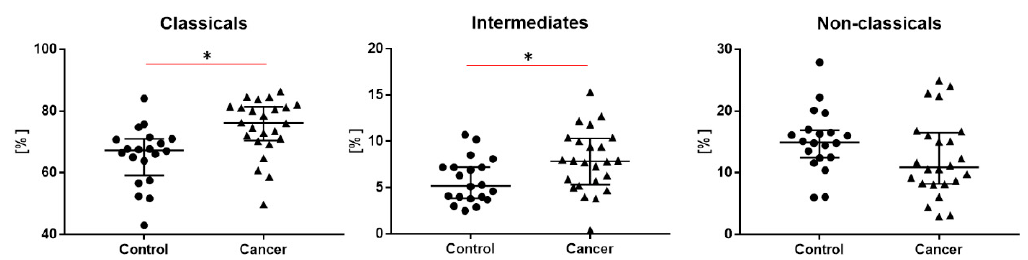
Figure 2. The differences of tree types of monocytes: classical, intermediate and non-classical monocytes between study and control groups. Graphs show the median values and quartile Q1–Q3, * p < 0.05.